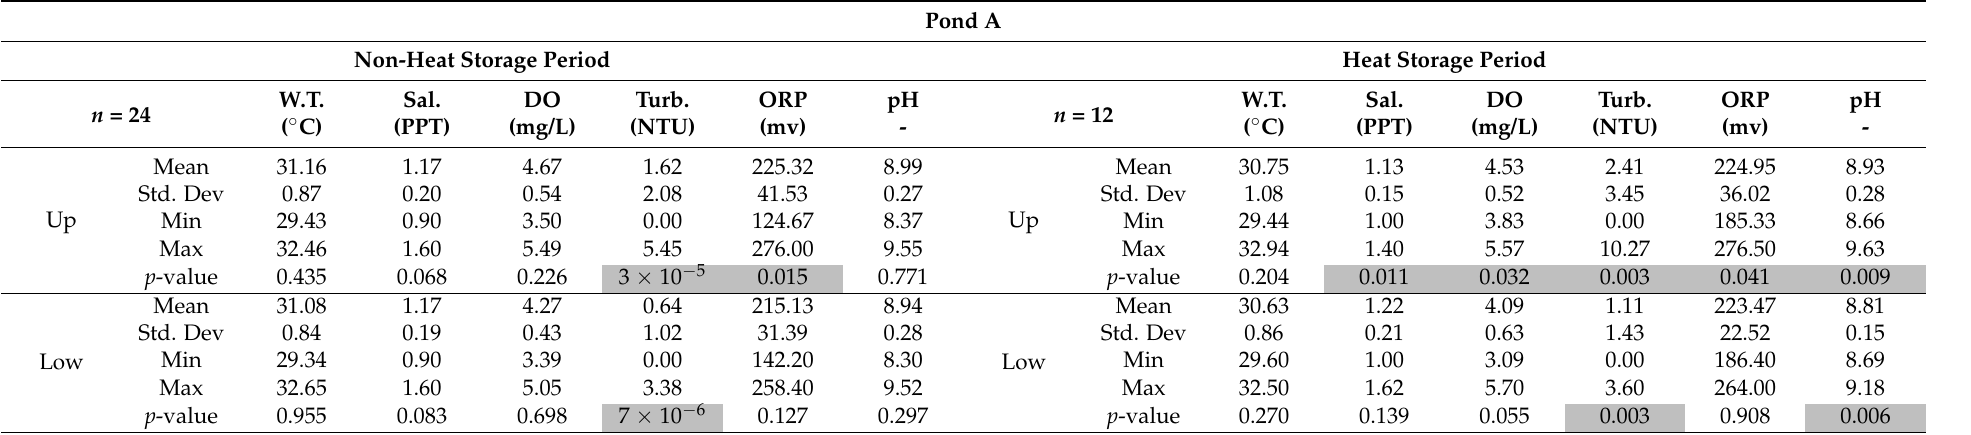
Table 4. Descriptive statistics for physical water quality parameter, divided into non-heat storage period and heat storage period, and into lower and upper heat storage layers. Pond A Non-Heat Storage Period Heat Storage